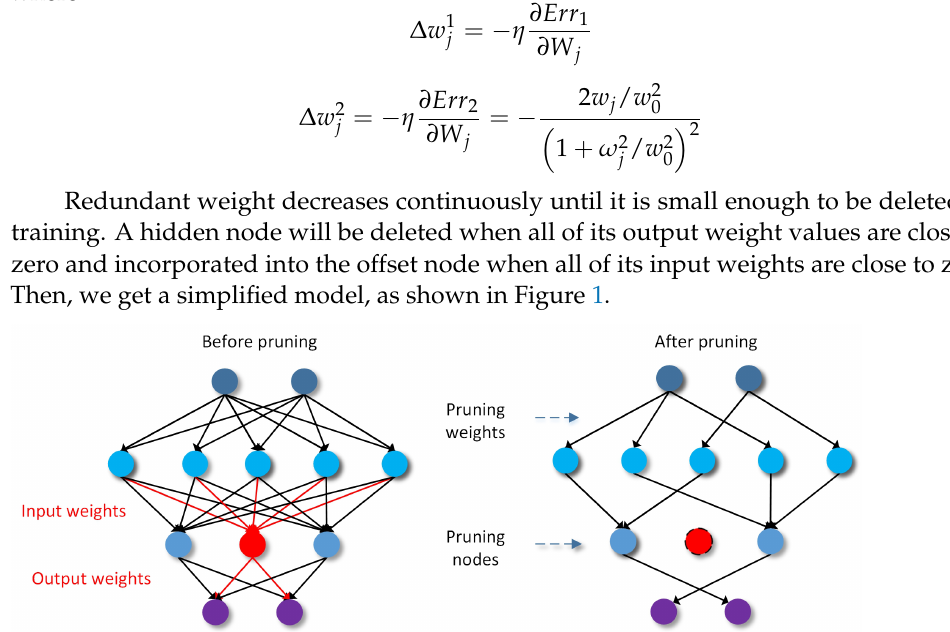
Figure 1. Illustration of pruning: The red node is pruned for all its input weight values that are close to zero with its bias transmitted to the next